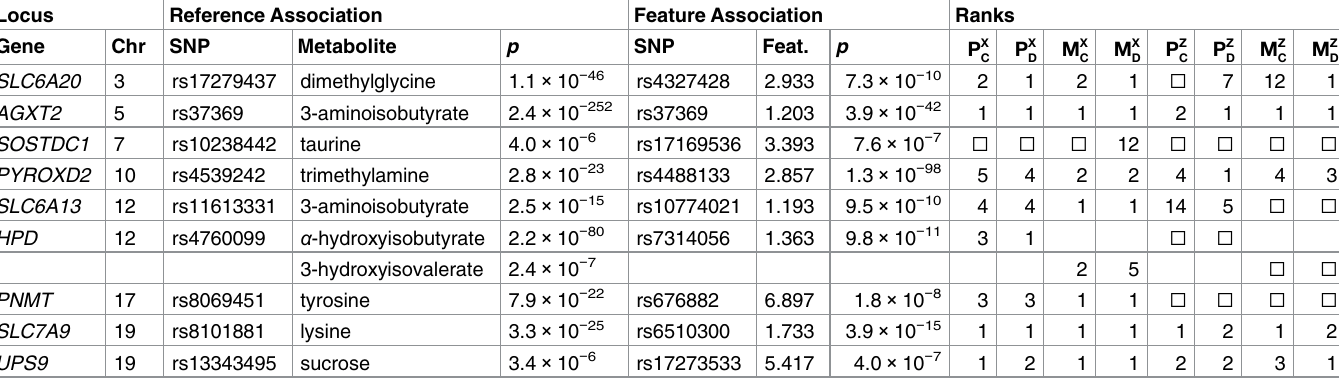
Table 1. CoLaus metabomatching results. Ranks of reference metabolitesobtainedfor CoLauspseudospectra, with UMDB as the spectral reference data- base, and with: peak- (P) or multiplet-mode (M), χ 2 - (X) or Z -scoring (Z), and without (C) or with decorrelation (D). Neighborhood parameter is δ = 0.03 in peak-mode, 0.01 in multiplet-mode. Shrinkage parameter is λ = 0.5 for decorrelation, 1 without. Referencemetabolites are obtained from testableassociations collectedfrom targeted mGWAS [8, 18, 19]. Squares ( □ ) indicateranks not in the top 10% of UMDB listed metabolites, that is ranks greater than 18. Individual metabomatching figures including the eight highestranked metabolitecandidatesfor each pseudospectrum can be found in S1 Fig. Due to the differences in the peak and multiplet descriptions, the associationof the HPD SNP with α -hydroxyisobutyrate is testable only in peak mode (S1F Fig), the associationwith 3-hydroxyisovalerate only in multipletmode (S1G